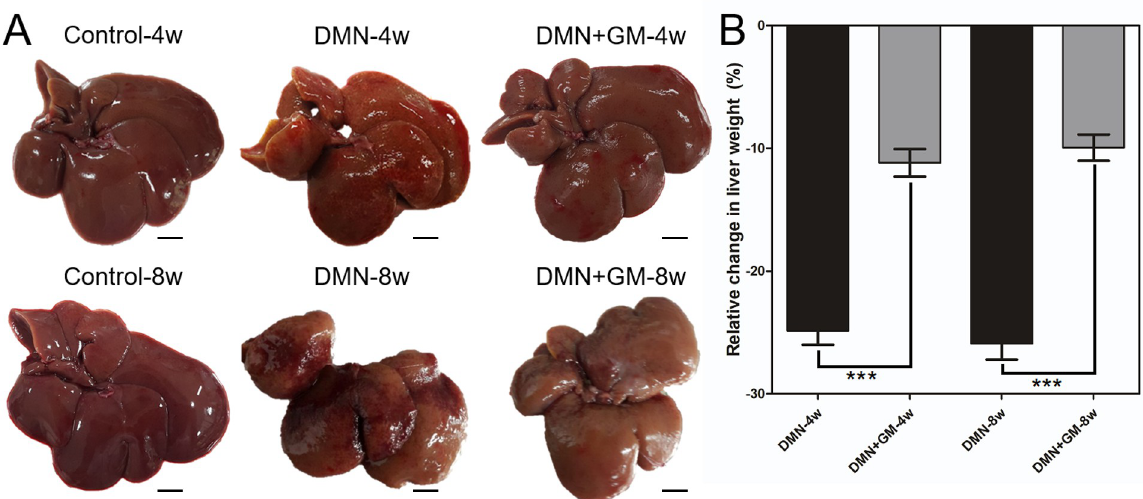
Fig 4. Effects of GM-CSF on DMN-induced changes in liver morphology, texture, and weight. ( A ) Images showing the morphology and texture of liver lobes in the control group, DMN-4w and -8w groups, and DMN+GM-4w and -8w groups. Note that DMN-treatment markedly changed both liver morphology and texture, and that GM-CSF treatment prevented DMN-induced changes in liver morphology and texture in the DMN+GM-4w and -8w groups. Scale bar = 1 cm. ( B ) Histograms showing changes in liver weight with respect to the corresponding controls in the DMN-4w and -8w and DMN+GM-4w and -8w groups. GM-CSF treatment significantly suppressed DMN-induced reductions in liver weight in both the 4- and 8-week treatment groups ( ��� p �